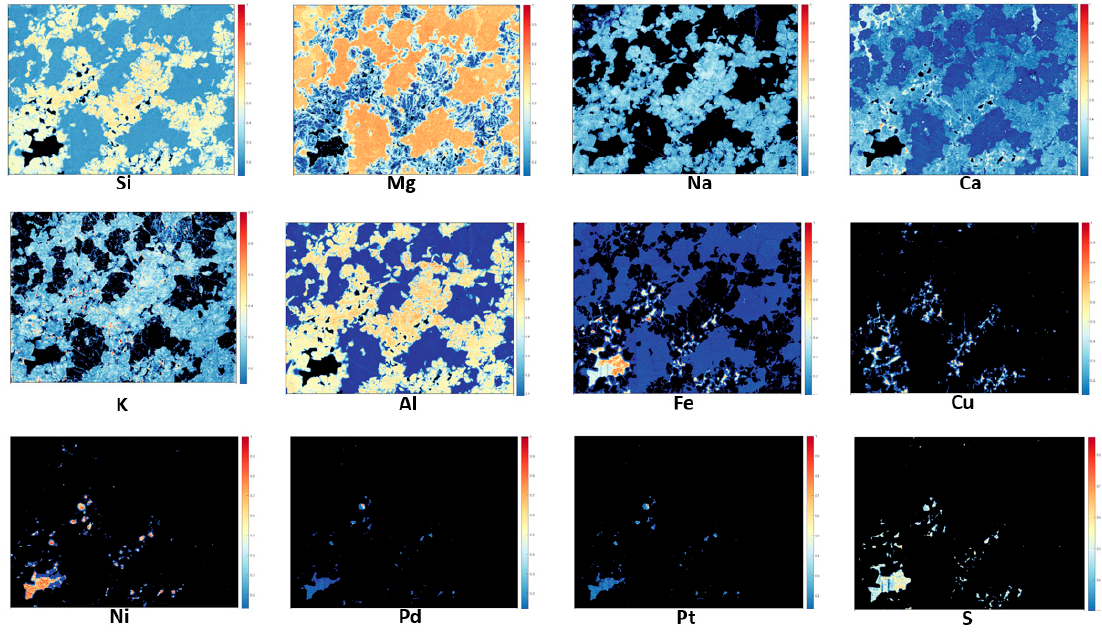
Figure 4. Single element mapping for Si, Mg, Na, Ca, K, Al, Fe, Cu, Ni, Pd, Pt, and S. The intensity of the selected line for each element is scaled between 0 (dark blue) and 1 (red), as shown by the color bars.